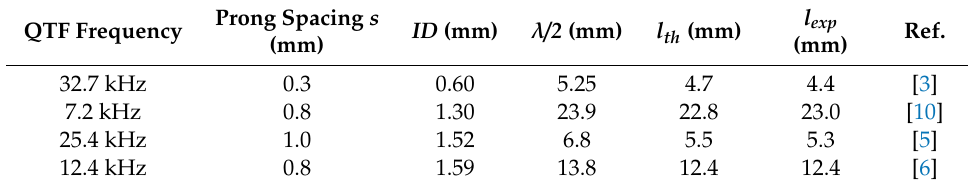
Table 1. Best geometry parameters of dual-tube spectrophones realized for four different QTFs operating at different frequencies: the prongs ’ spacing ( s ), the internal diameter of the tube ( ID ), the sound half wavelength (λ/2), and the theoretical ( l th ) and experimental ( l exp ) optimal tube lengths.